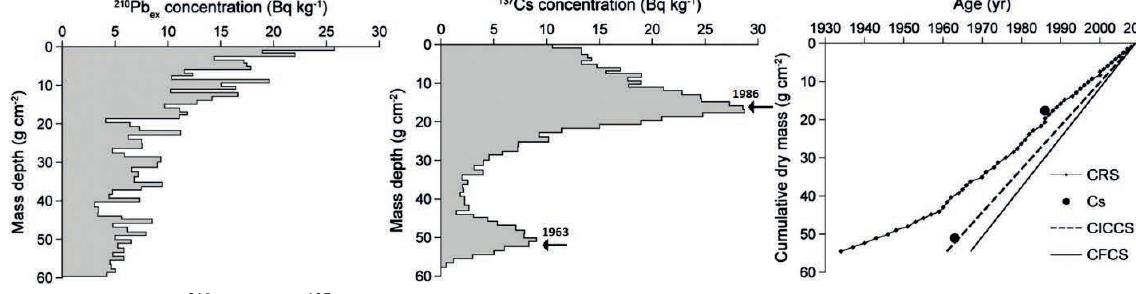
Fig. 1 The 210 Pb ex and 137 Cs profiles associated with a sediment core collected from the floodplain of the River Severn, UK, and a comparison of the age–depth relationships derived from the 210 Pb ex data using the CRS, CICCS and CFCS models and from the 137 Cs depth distribution (based on Du & Walling,